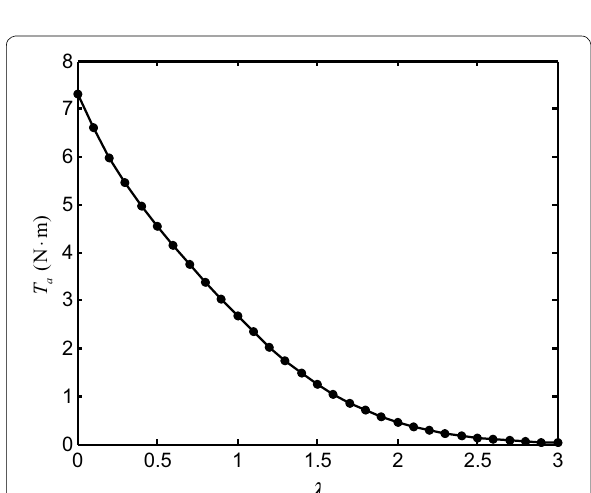
Figure 12 Variation of actual oil film thickness and nominal film thickness with film thickness ratio